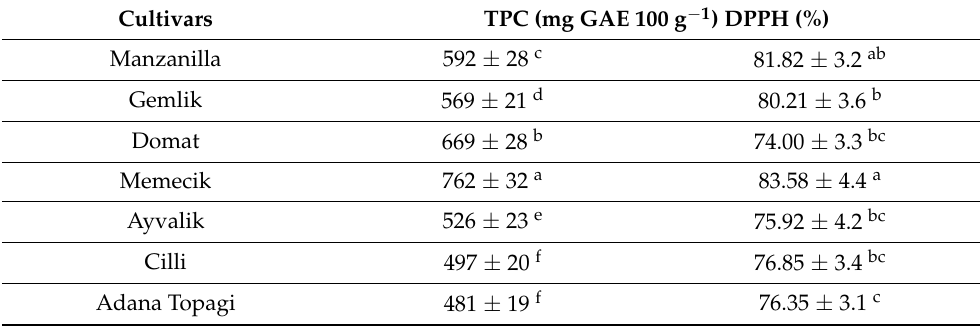
Table 3. TPC content and DPPH scavenging activity of cultivar’s olive fruit ( n = 3).